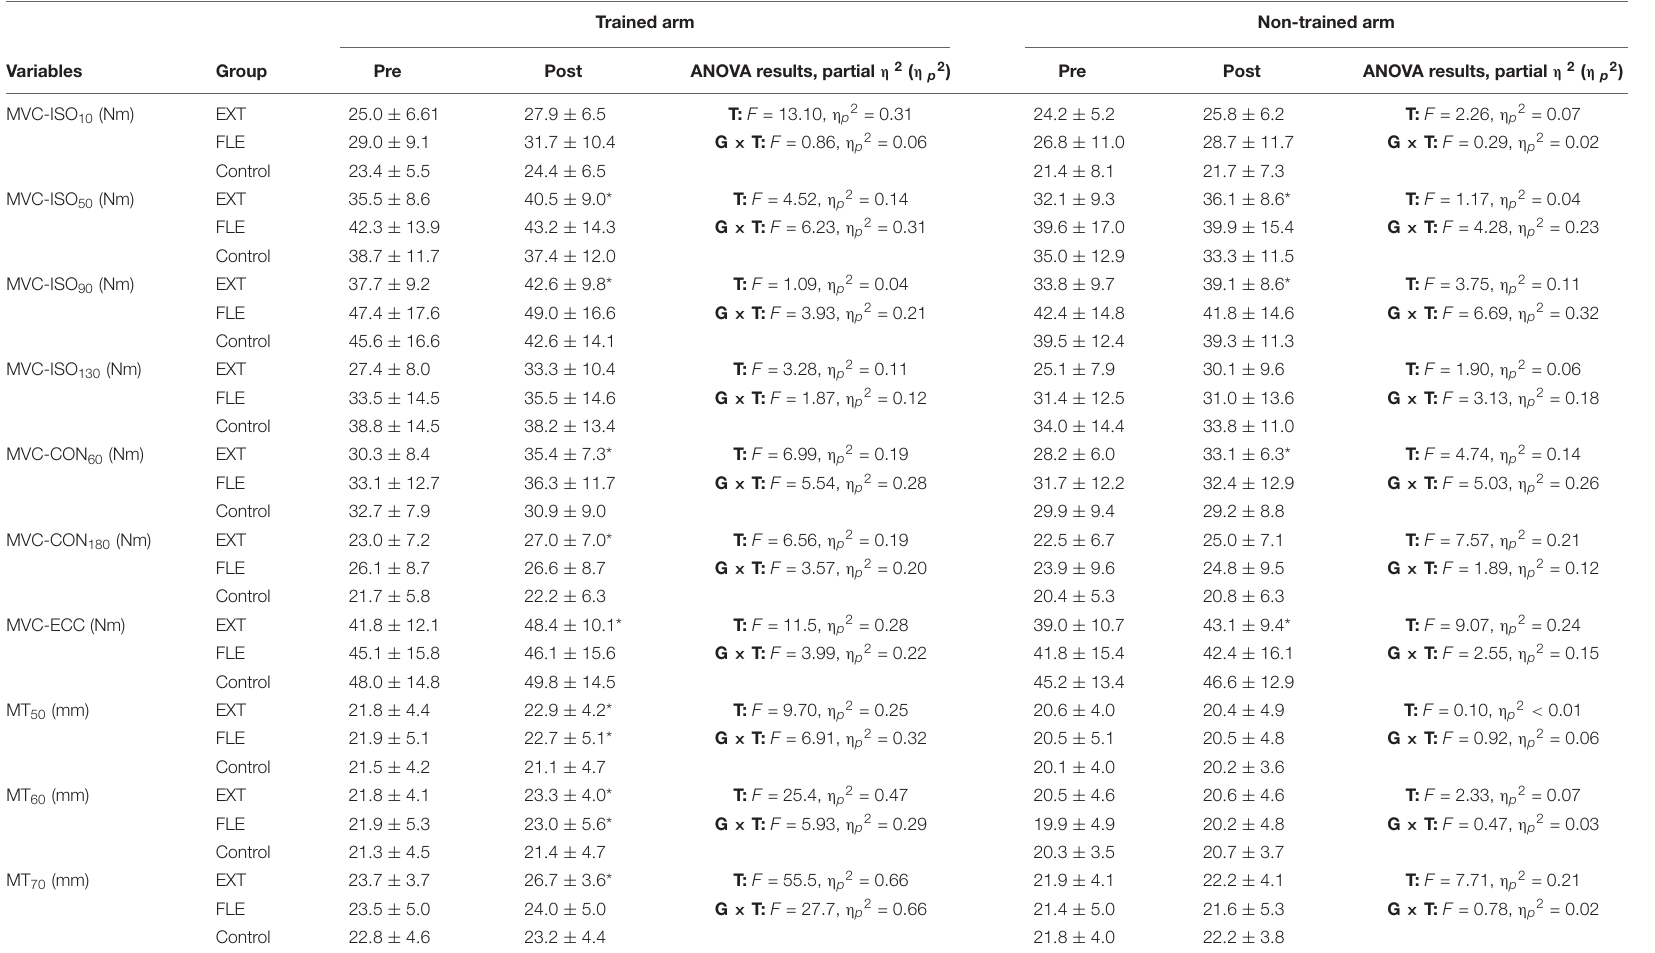
The two-way ANOVA results (T: time effect, G × T: group × time interaction effect; F-value) and partial η 2 ( η p2 ) are shown for the trained and non-trained arms. *: significant (p < 0.05) difference from the PRE